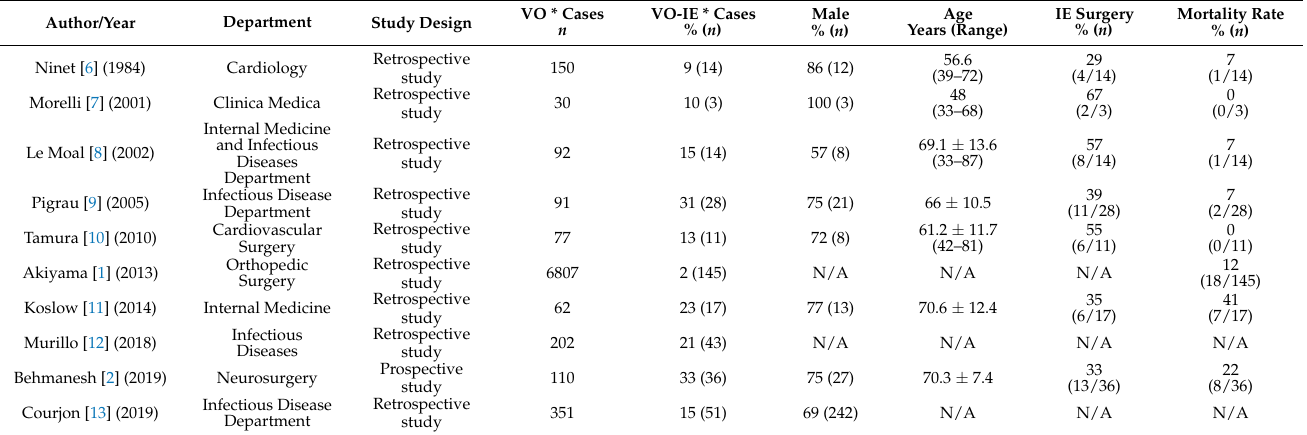
Table 1. Previous reports of vertebral osteomyelitis and infective endocarditis